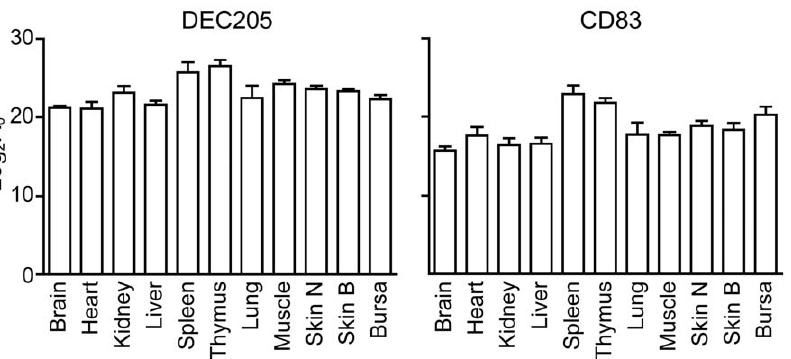
Figure 2. Transcript levels of DEC205 and CD83 genes in tissues. The vertical scale represents transcript levels relative to the reference 28S RNA on a logarithmic (base 2) scale. Bars indicate the levels in each of the tissues indicated below the horizontal axis. Error bars indicate the standard error of three assays carried out on RNA preparations from tissue samples from different birds. doi:10.1371/journal.pone.0051799.g002 protein with human IgG1 Fc (Figure S4) and used to raise monoclonal antibodies. Six hybridomas secreting antibody specif- ically recognising the CD83 part of the fusion protein in ELISA assays were cloned. These were further tested by flow cytometry for binding to chicken splenocytes, and the antibody IAH F890:GE8 (IgG2a) was selected for further use. This was shown to react with the native chicken CD83 molecule expressed on the surface of transfected COS cells (Figure S6).